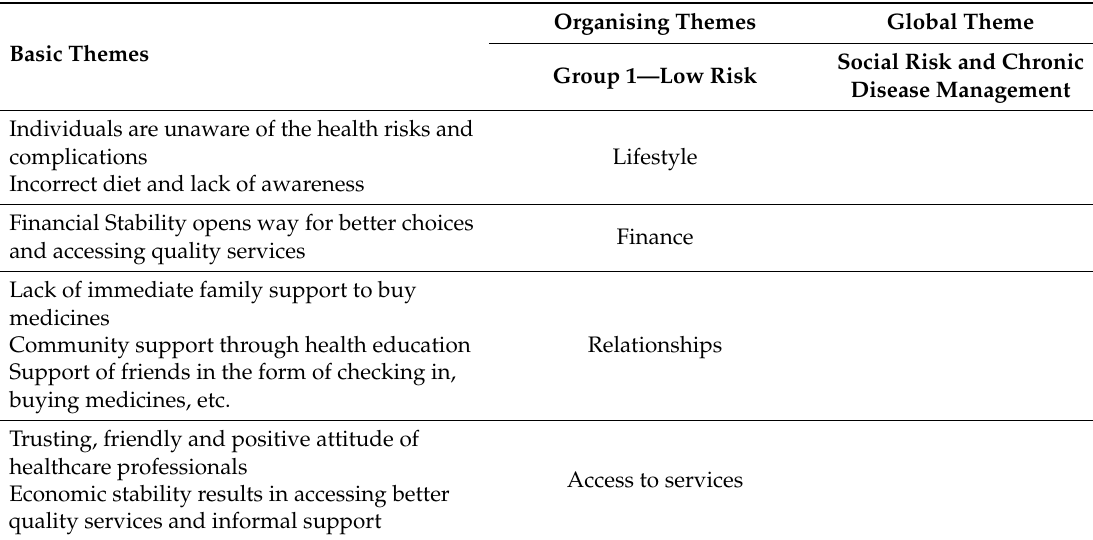
Table 1. Summary of themes from community